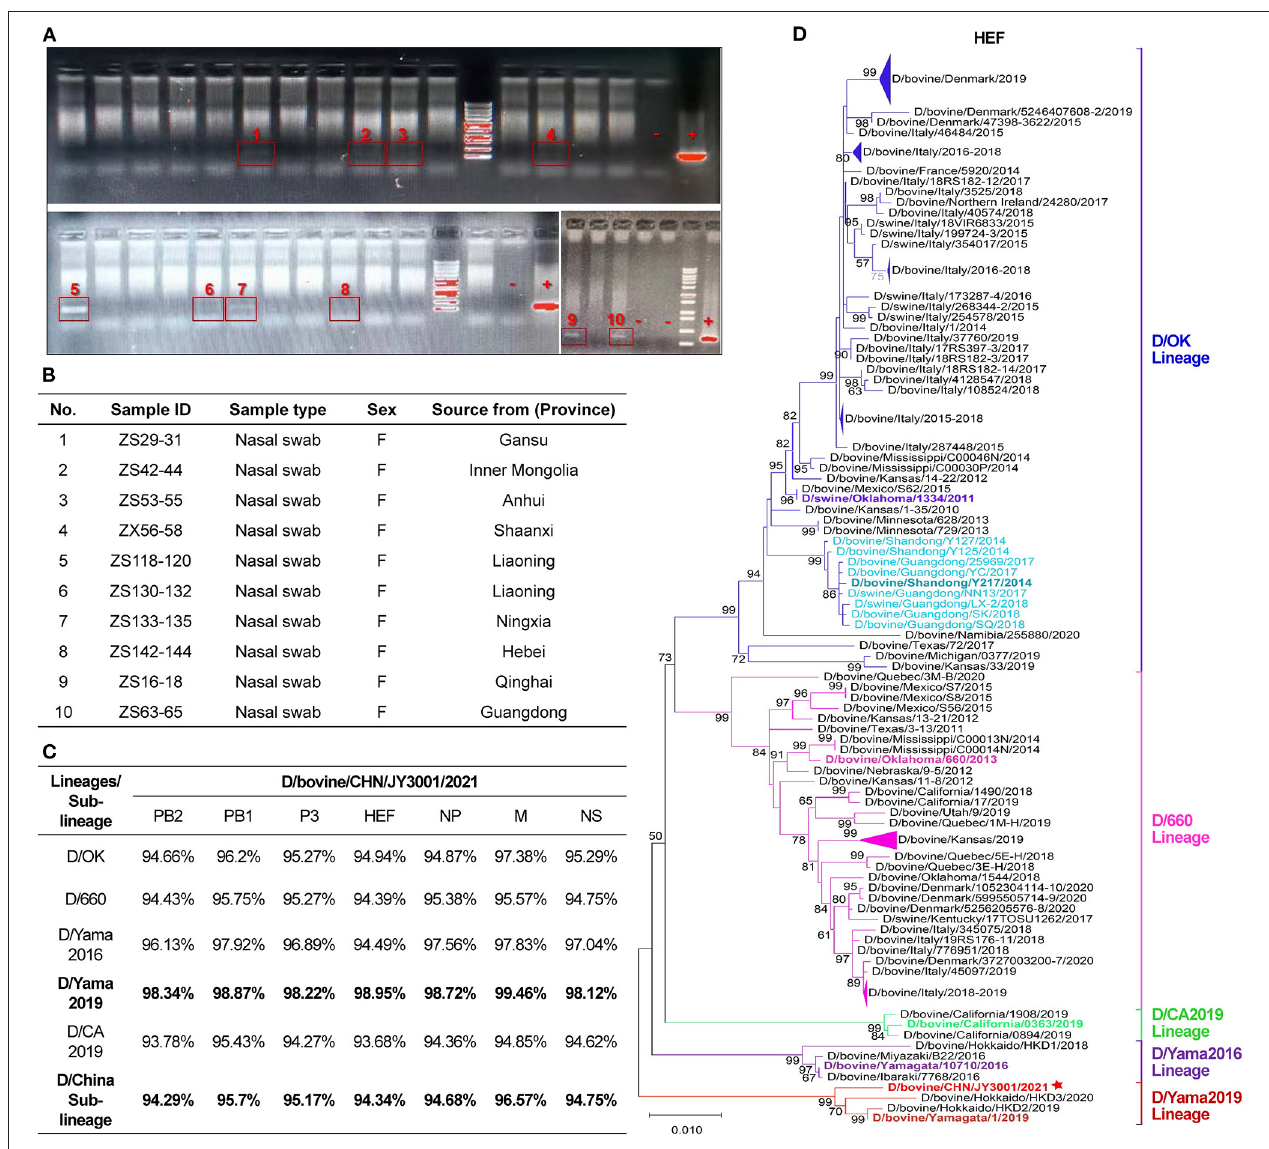
FIGURE 1 | Detection and characterization of influenza D virus in nasal swab samples of cattle. (A) Agarose gel electrophoresis analysis of the amplicon products resulting from RT-PCR using the designated forward and reverse primers to amplify a fragment of 382 bp of IDV P42 gene. IDV-positive samples were labeled and highlighted with red boxes. “–”: negative controls; “ + ”: positive controls. (B) IDV-positive samples identified in this study. The sample ID and type reported together with animal information (sex and source). (C) Nucleotide sequence alignments of individual segments of the IDV isolate found in this study and representative strains